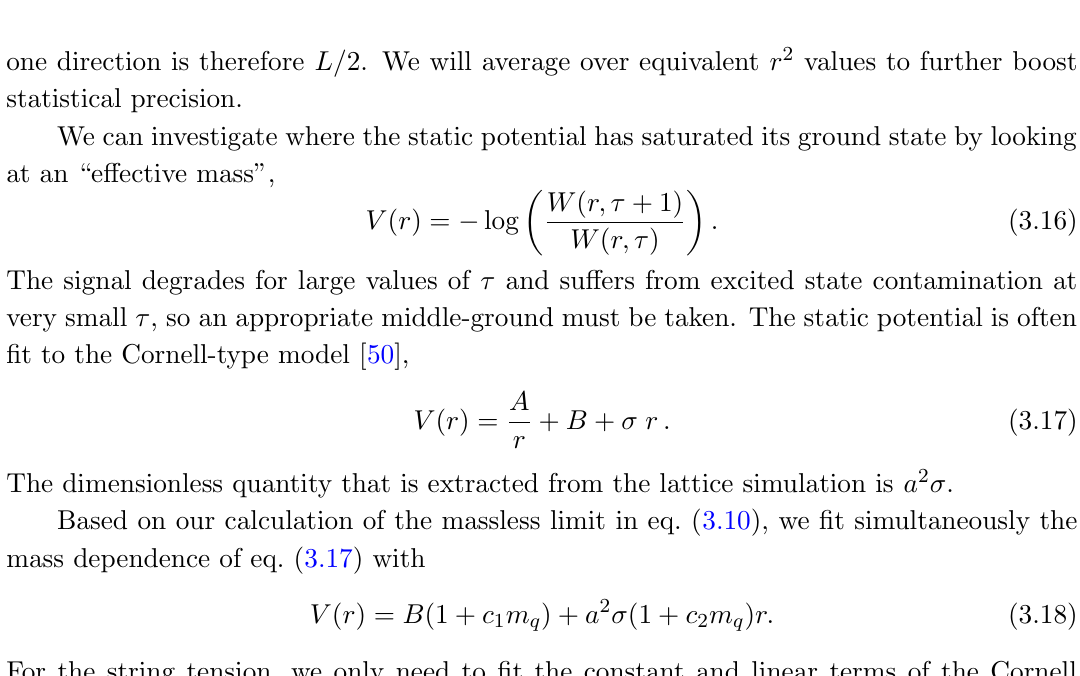
Figure 1 . Left panel: (cid:12)t of the 12 3 (cid:2) 32 static potential to eq. (3.18). Right panel: extrapolation of the square root of the string